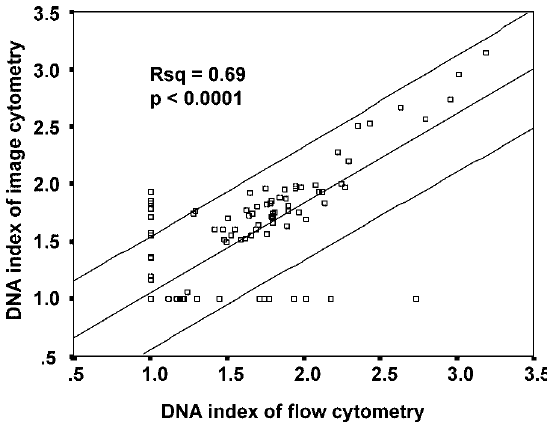
Fig. 1. Urothelial cell carcinomas (UCs). Scatterplot of DNA Indices (DI) obtained by flow cytometry (FCM) and image cytometry (ICM) in 202 cases. Note the correlation but also the variation. The cases with a FCM aneuploid ICM diploid cell line can be caused by clumps not recognized by FCM. The flow-cytometrically diploid ICM ane- uploid cases can be caused by the better detection properties of rare near-diploid aneuploid cells.